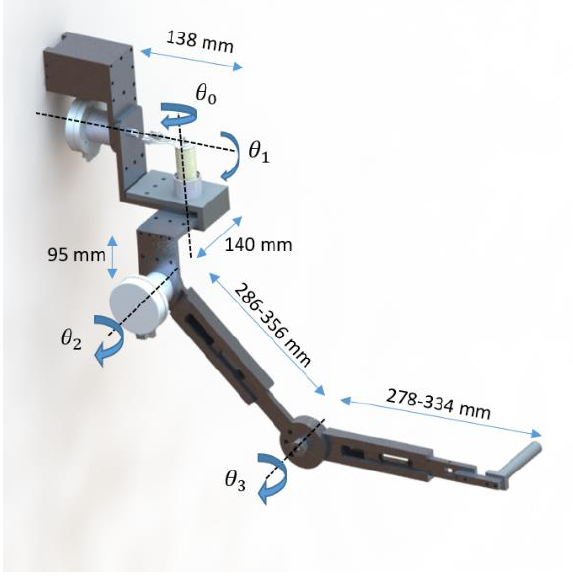
Figure 7. Link – frame attachments Table 4. Denavit – Hartenberg parameter